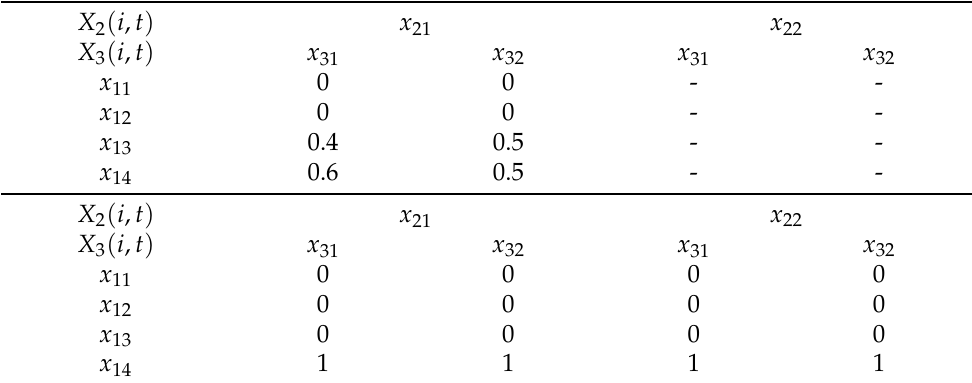
Table 11. CPDs of the future state with one four infectious devices and with the initial states: damaged (on the left) and recovered (on the right).